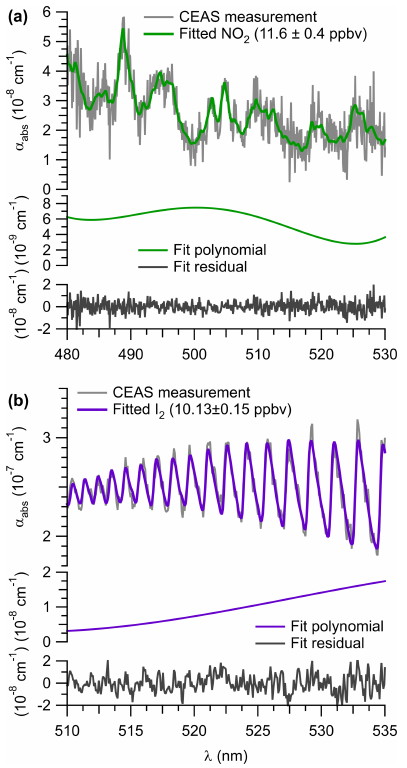
Figure 5. Spectral fits to 60s IBBCEAS signal, including a third- order polynomial and fit residual, for (a) NO 2 (ambient) and (b) I 2 (calibration) during the ORCA field